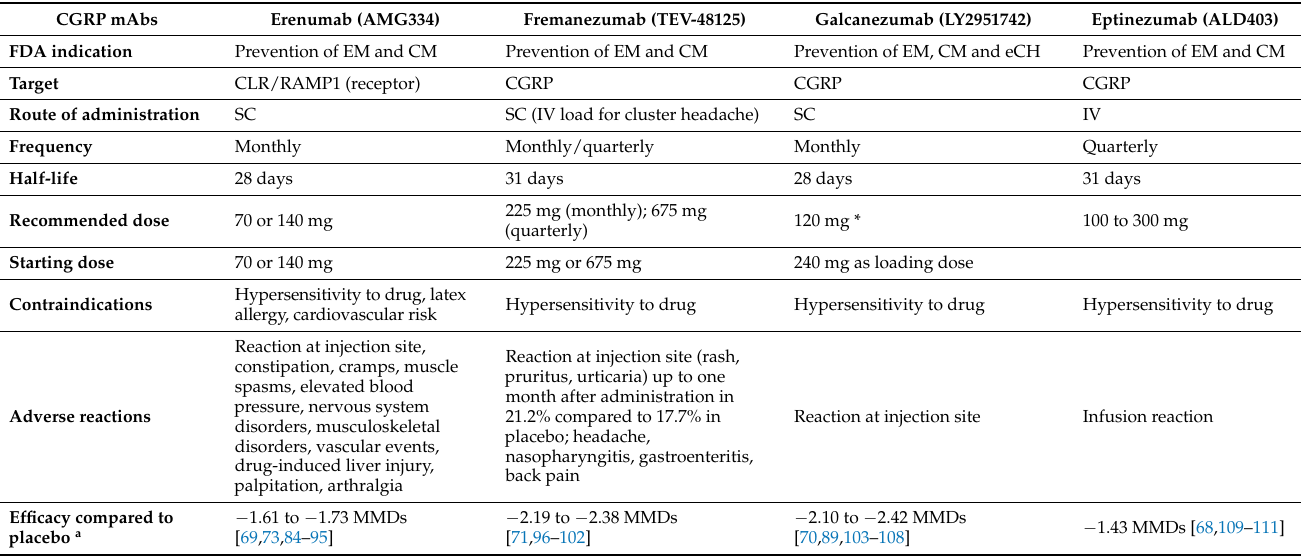
Table 2. Comparison of four anti-CGRP mAbs for migraine prevention. CGRP: calcitonin gene- related peptide; CM: chronic migraine; eCH: episodic cluster headache; EM: episodic migraine; FDA: Food and Drug Administration; IV: intravenous; mAbs: monoclonal antibodies; SC: subcutaneous. a Results according to available meta-analysis. * For episodic CH the recommended dose is 300